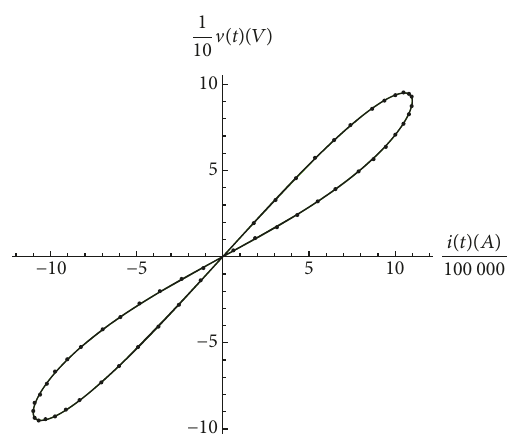
Figure 9: V (𝑡) - 𝑖(𝑡) of the fractional order memristor (green) and HP memristor (black dots): 𝛼 = 1 and 𝐼 𝑚 > 0.